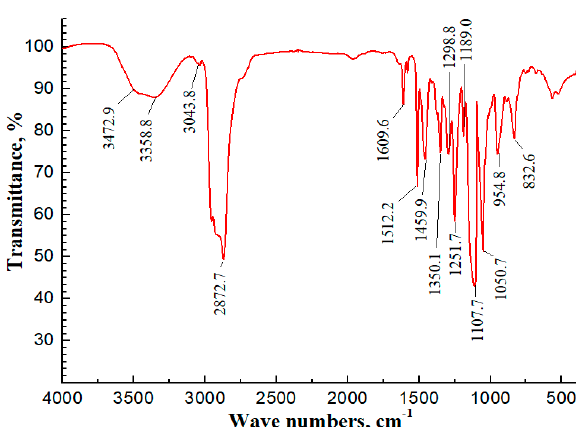
Figure 4. IR spectrum of surfactant SDY-1 in KBr.